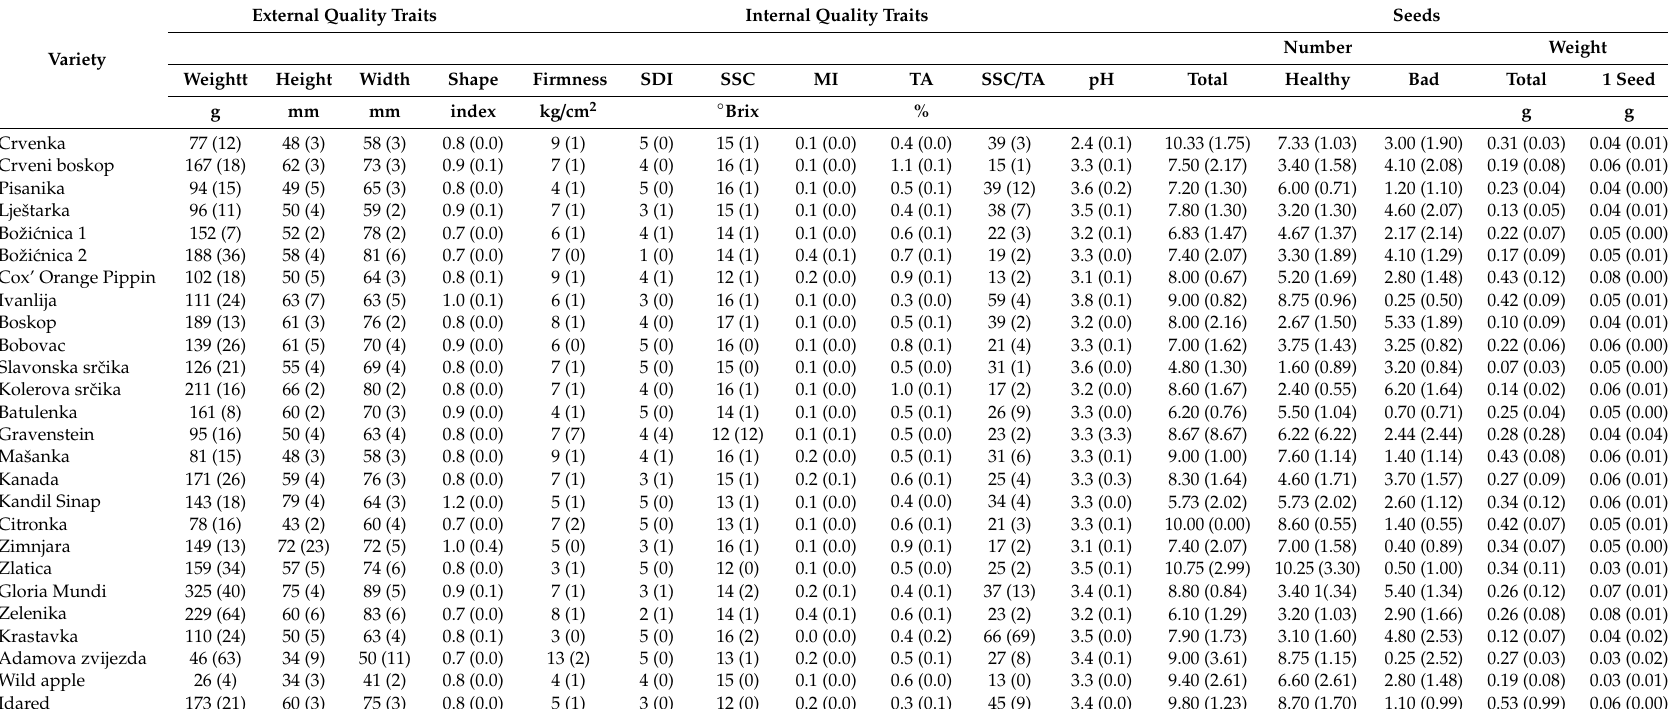
Table 1. Basic external and internal fruit quality parameters and seed